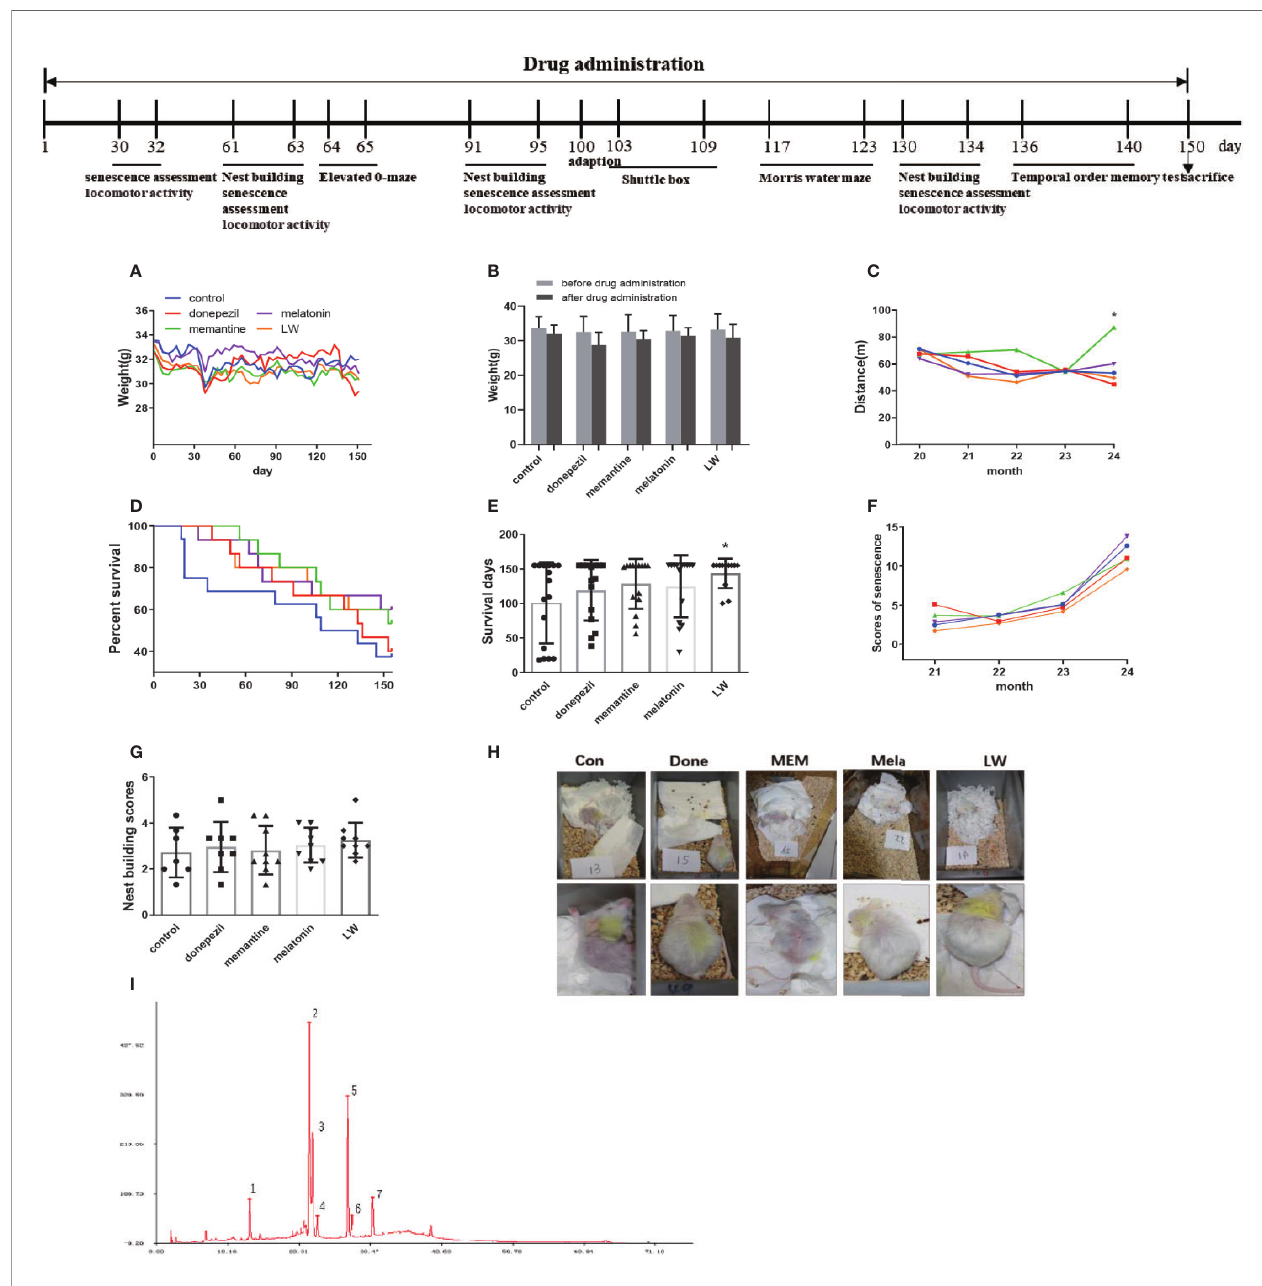
FIGURE 1 | The experimental timeline and the effects of donepezil, memantine, melatonin, and LW on the aging performance of old SAMR1 mice. (A) The weight of mice during drug administration. (B) The locomotor activity of mice during drug administration. (C) The score of mouse nest building after 3 months of treatment. (D) The percentage survival of the mice. Log-rank test of survival curve, P=0.1. (E) Survival days of mice. (F) The aging degree score of mice during drug administration. One-way ANOVA and Dunnett test, mean ± S.D., n=13~16 (male: n = 4~6, female: n = 7~9). (G) The nest building scores. (H) Performance of nest building and fur of mice. (I) The peak of 1, 2, 3, 4, 5, and 7 are the main compounds a -morroniside, b -morroniside, oxypaeoni fl orin, loganin, paeoni fl orin, and 5- hydroxymethylfurfural of LW,